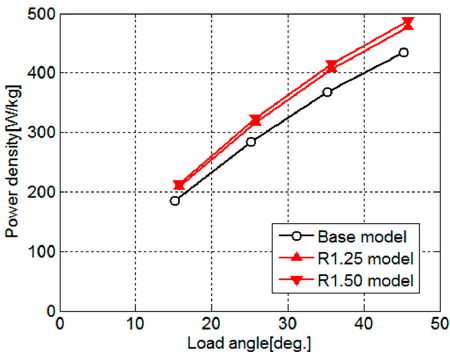
Figure 15. Comparison of torque waveforms in the Bezier model, R1.25 model, and R1.50 model.